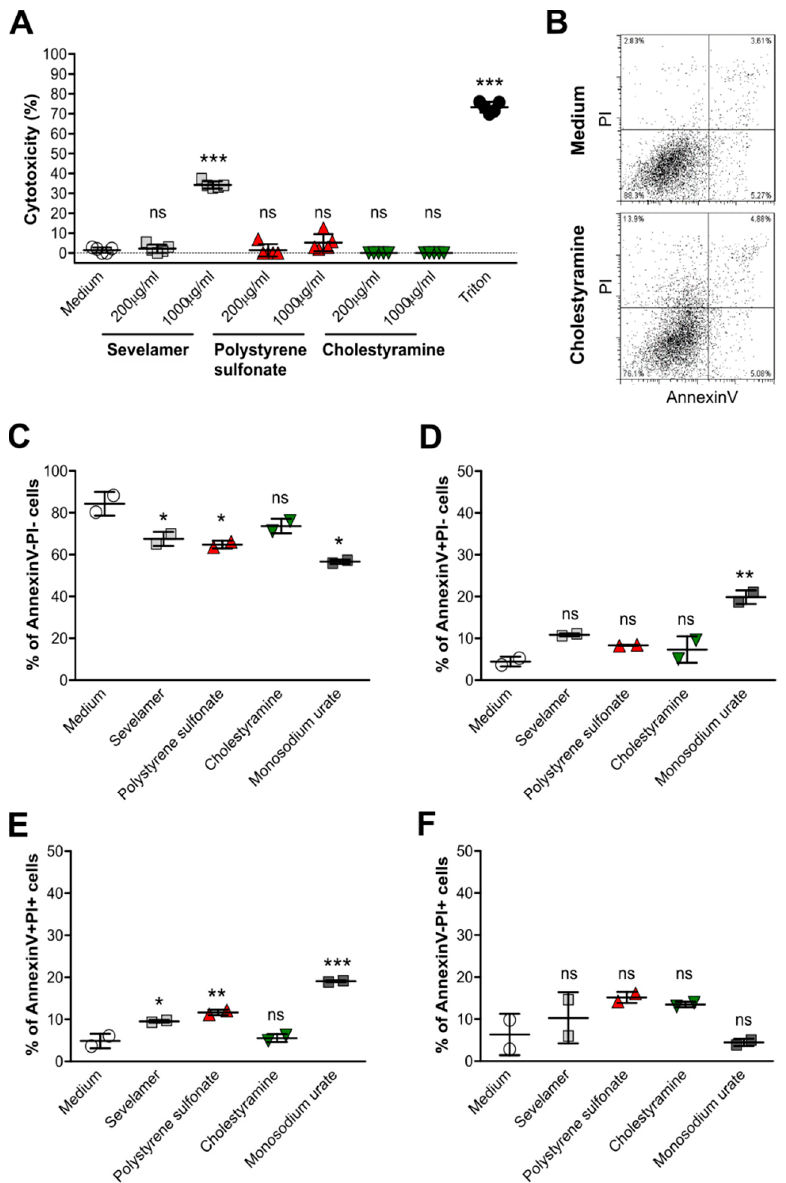
Figure 3. Crystals of ion-exchange resins induce cell death in Caco2 intestinal epithelial cells. Human Caco2 intestinal epithelial cell lines were stimulated with different concentrations (200 or 1000 µg/mL) of sevelamer, polystyrene sulfonate, cholestyramine, or monosodium urate crystals for 24 h. Triton was used as a positive control. ( A ) After stimulation, culture supernatants were collected and lactate dehydrogenase (LDH) assays was performed. Cytotoxicity is presented as a percentage (%) ( n = 5). ( B – F ) AnnexinV/propidium iodide (PI) staining of Caco2 cells was performed by flow cytometry ( B ).